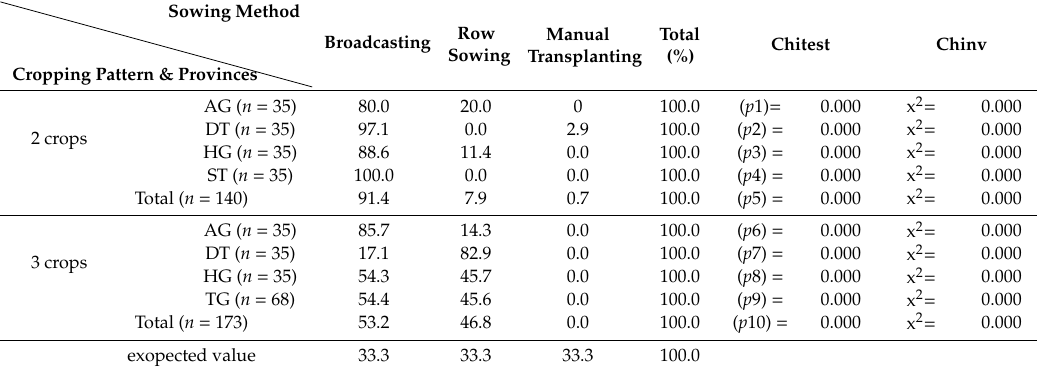
Table 7. Share of rice sowing method in Summer–Autumn season by province (%).